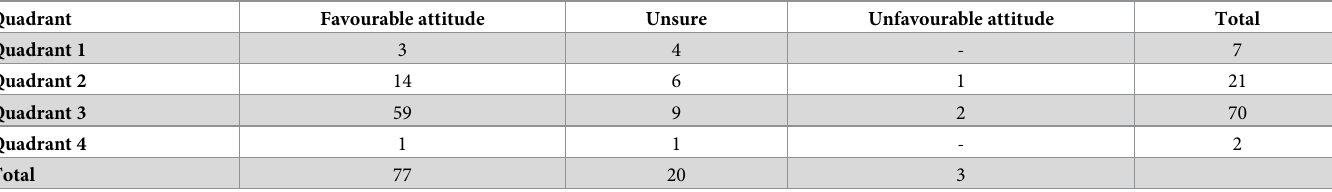
Table 4. I 3 mapping for testing.